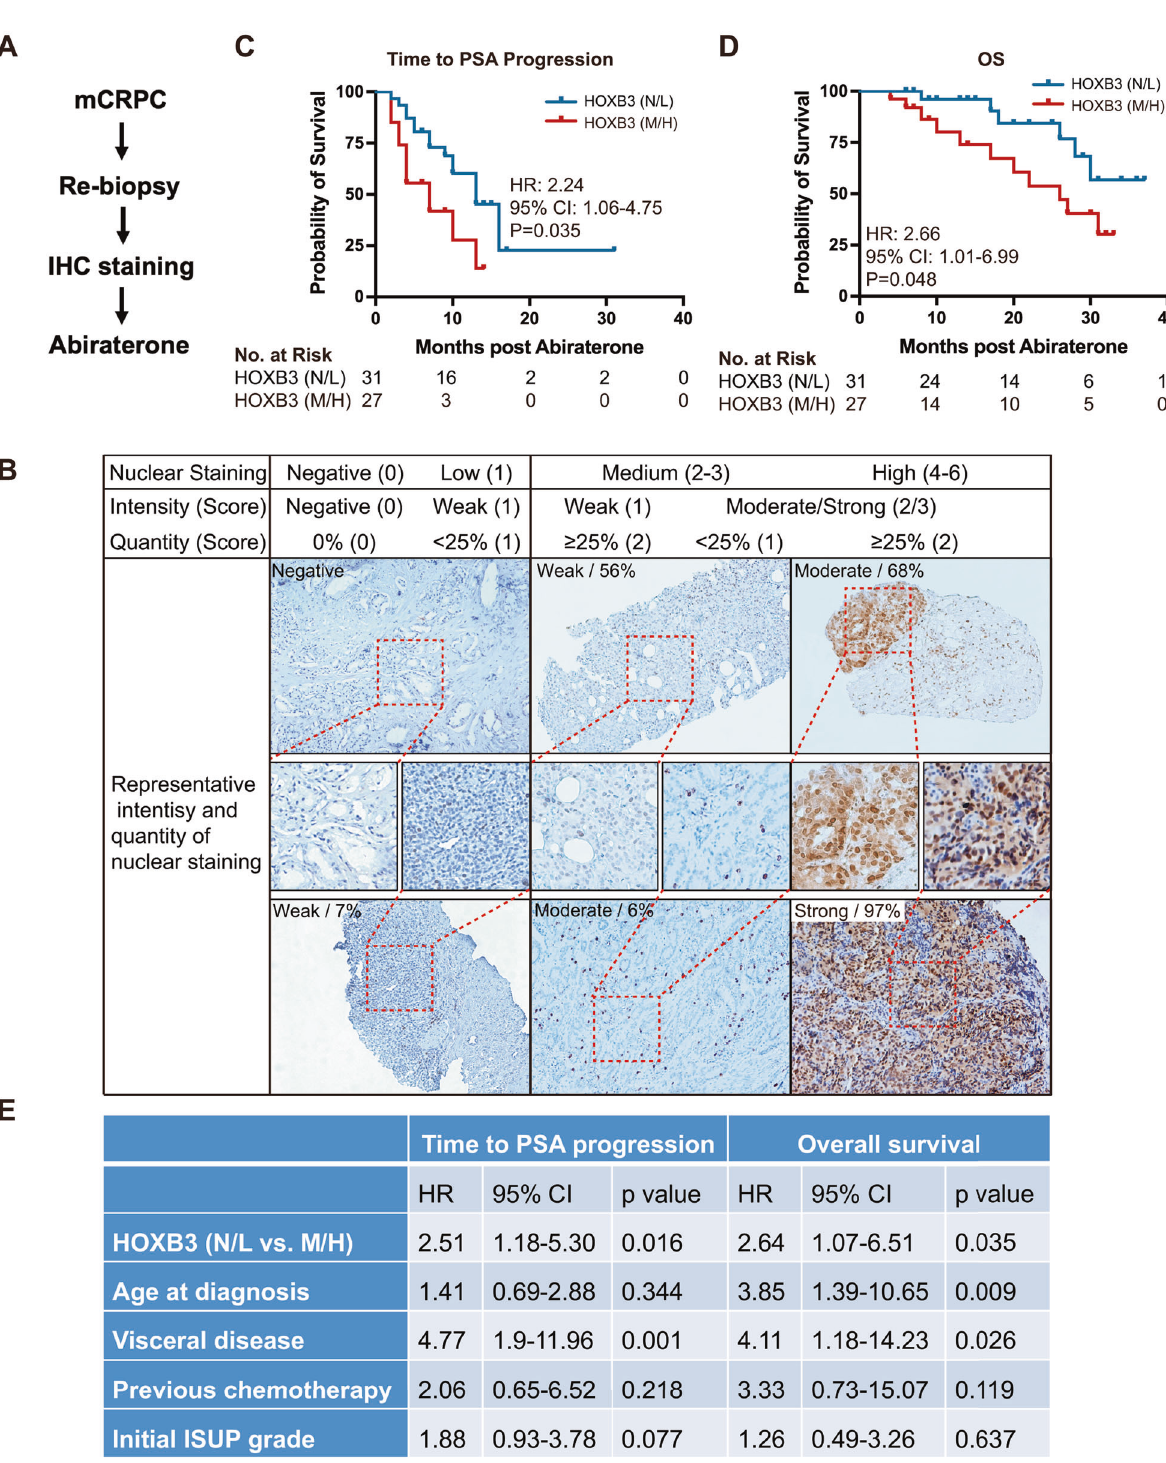
Cell Death and Disease (2023)